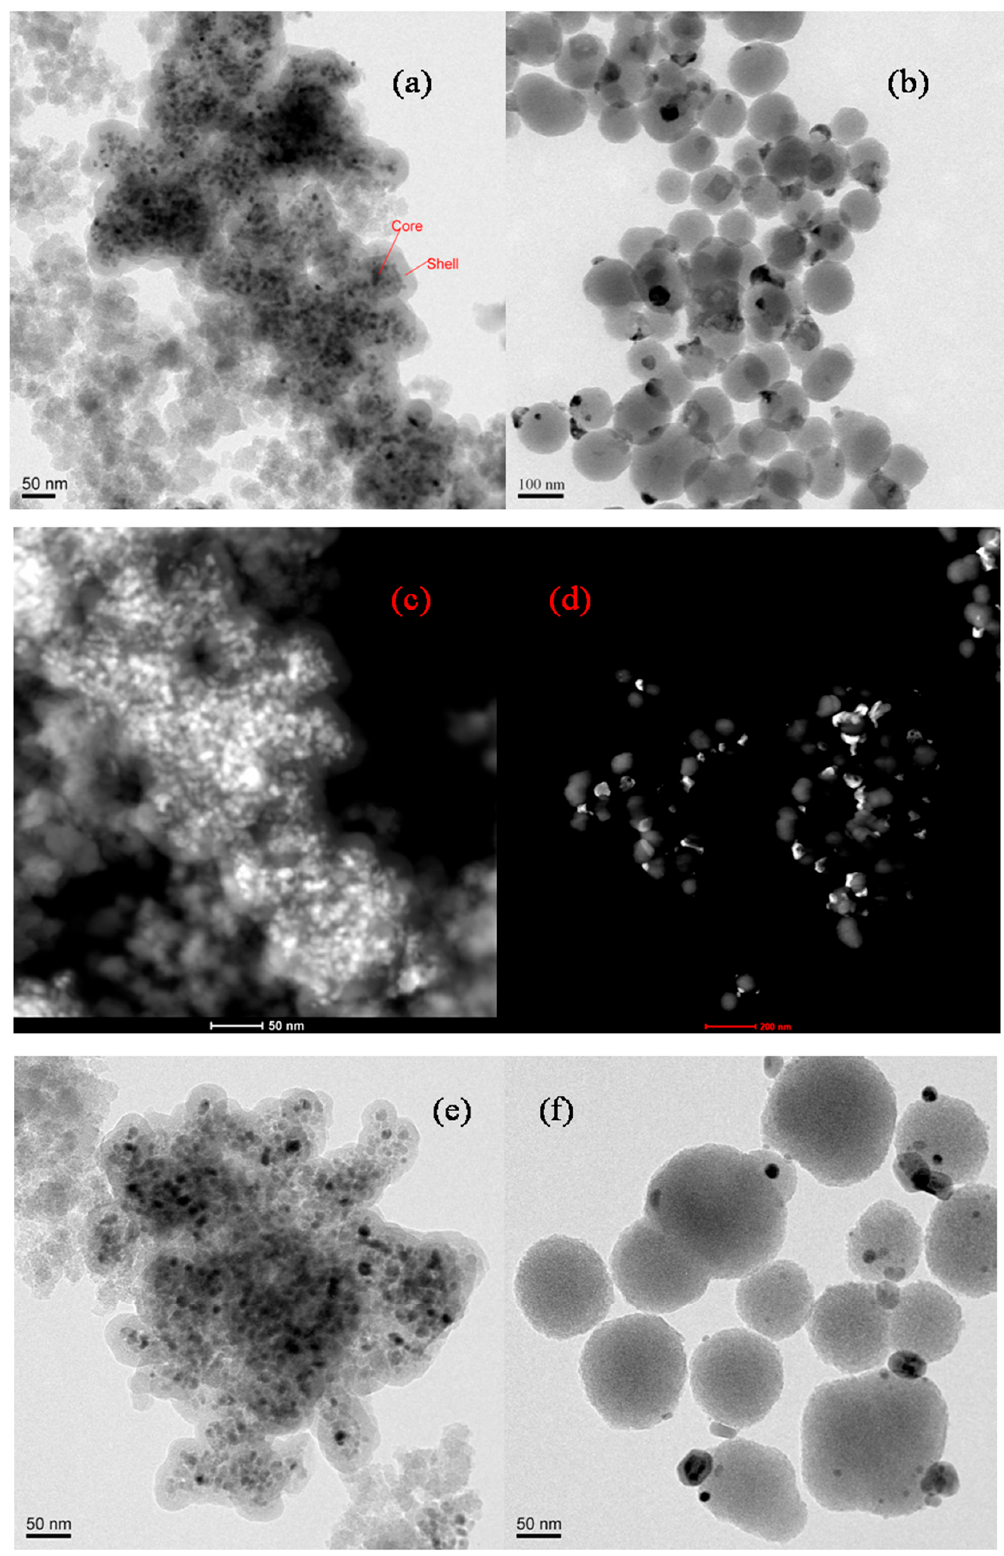
Figure 3. Transmission Electron Microscopy (TEM) images of as-obtained ( a ) NiO@SiO 2 ; ( b ) NiO/SiO 2 ; HAADF-STEM image of ( c ) NiO@SiO 2 and ( d ) NiO/SiO 2 ; TEM images of samples ( e ) NiO@SiO 2 and ( f ) NiO/SiO 2 , both after hydrogen treatment at 550 °C, 3 h.